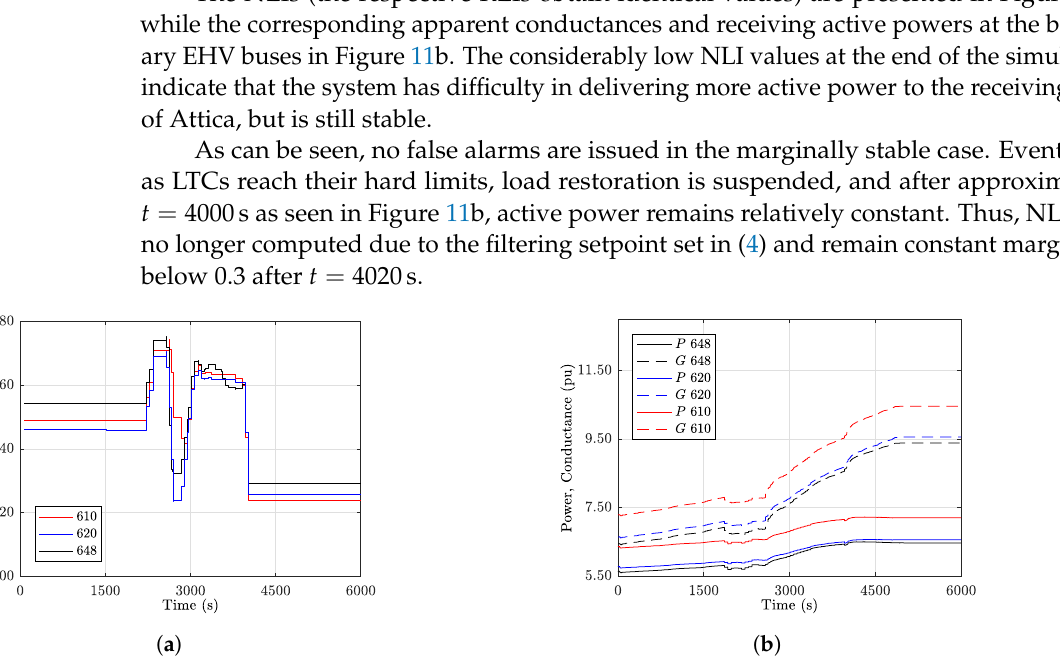
Figure 11. Stable scenario response of ( a ) NLI response and ( b ) active power transfer & apparent conductance at EHV buses 610 (Acharnon), 620 (Koumoundourou) and 648 (Ag.